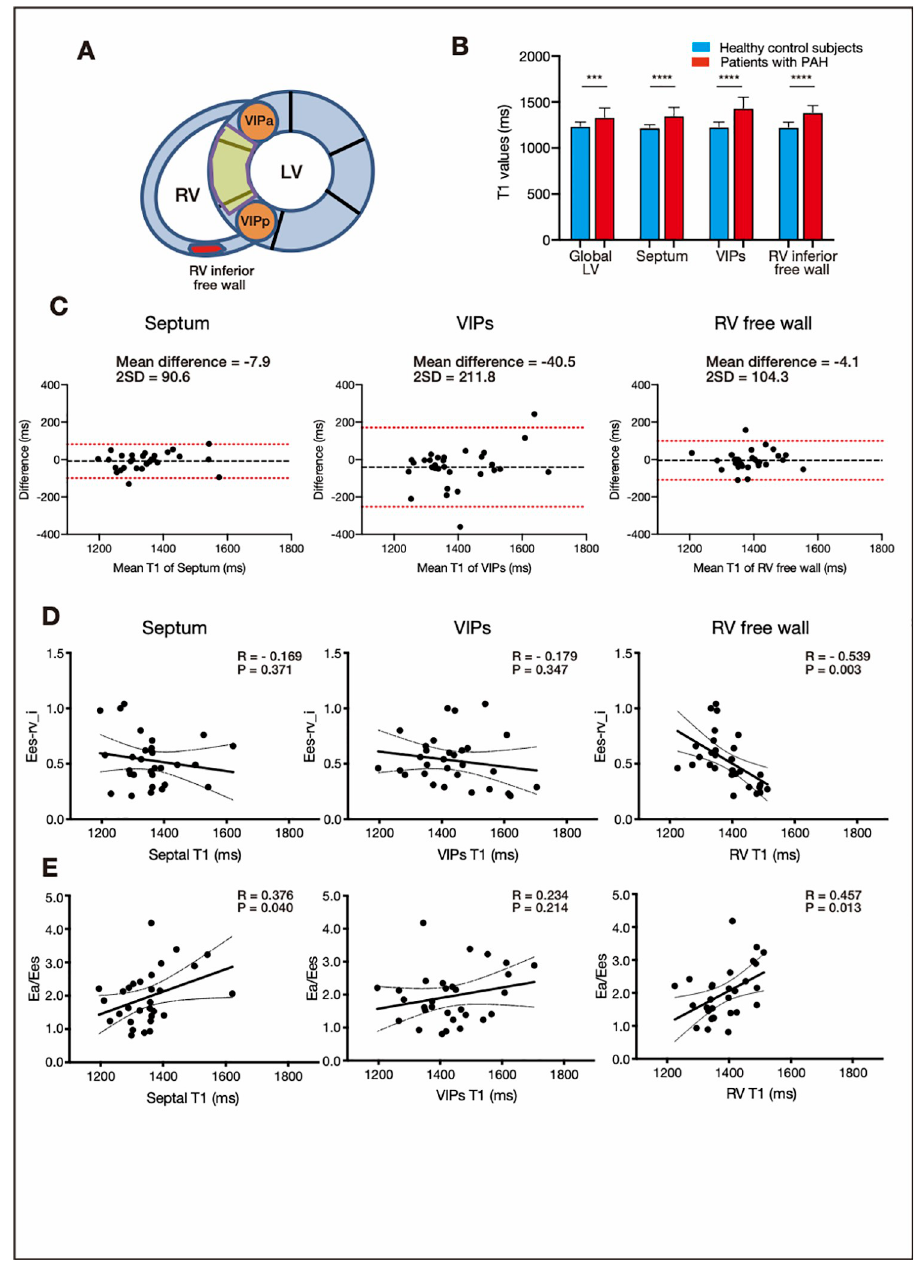
Fig 1. Measurement regions in the right ventricle (RV) and comparisons of T1 values. (a) ROIs of the septum and VIPs are marked in yellow and orange, respectively. ROIs of the RV free wall evaluated in the inferior part are marked in red. (b) Bar plots of native T1 values at each measurement site. The blue and red bars indicate T1 values of patients with PAH and healthy controls, respectively. (c) Interobserver variability analyzed by the Bland–Altman plot. (d) Correlations between T1 values at each measurement site and effective RV elastance using the single-beat method. (e) Correlations between T1 values at each measurement site and RV-pulmonary arterial coupling. Abbreviations: Ea-pa, effective pulmonary arterial elastance; Ees-rv, effective right ventricular elastance; LV, left ventricle; PAH, pulmonary arterial hypertension; ROI, region of interest; RV, right ventricle; VIPs, interventricular insertion points.